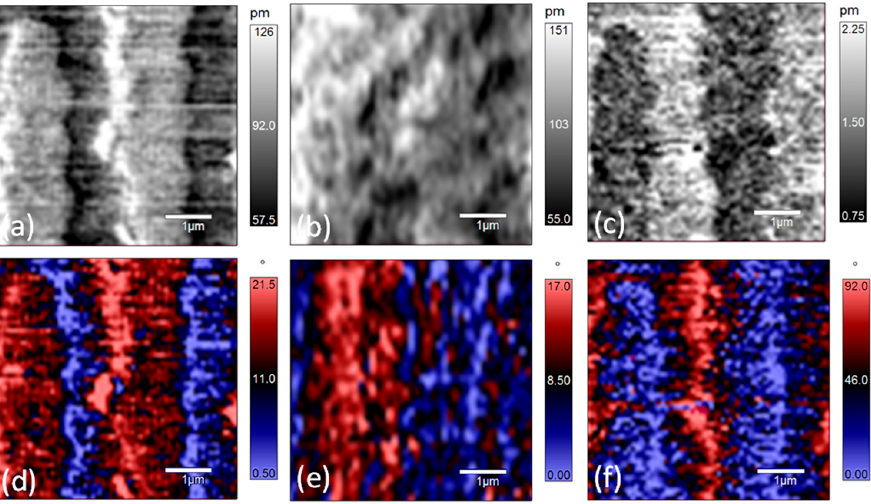
Figure 7. PFM amplitude and phase of [001]-cut PZN-7%PT single crystal at 170 ◦ C: ( a – c ) amplitude images of x-LPFM, y-LPFM, and VPFM, respectively; and ( d – f ) phase images of x-LPFM, y-LPFM, and VPFM, respectively.